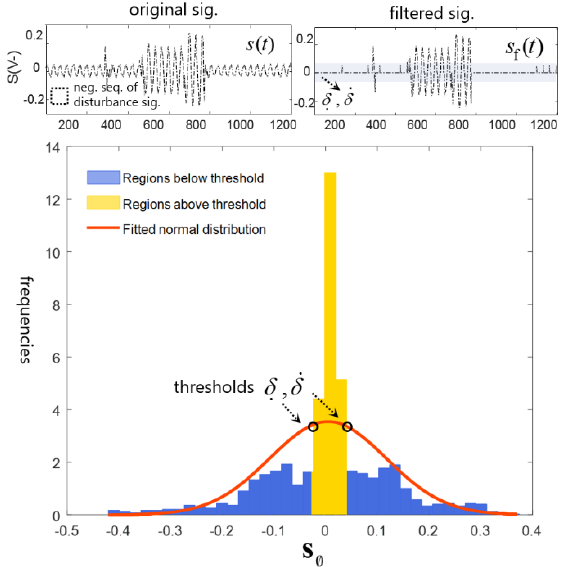
Figure 3. Illustration of the sequence value histogram and applied noise filtering example.